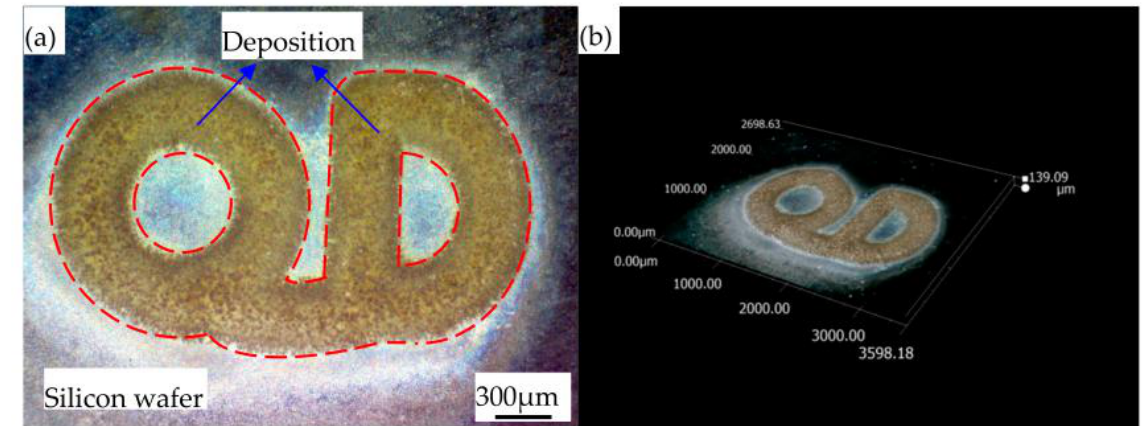
Figure 17. Example of HV- µ EAM metal layer of ‘QD’ letter ( a ) metal layer in the scope of 3 mm × 2 mm in X-Y plane and 139.09 µ m in height using 200 µ m electrode and ( b ) the photo of metal layer of ‘QD’ letter observed by Ultra Depth of Field 3D